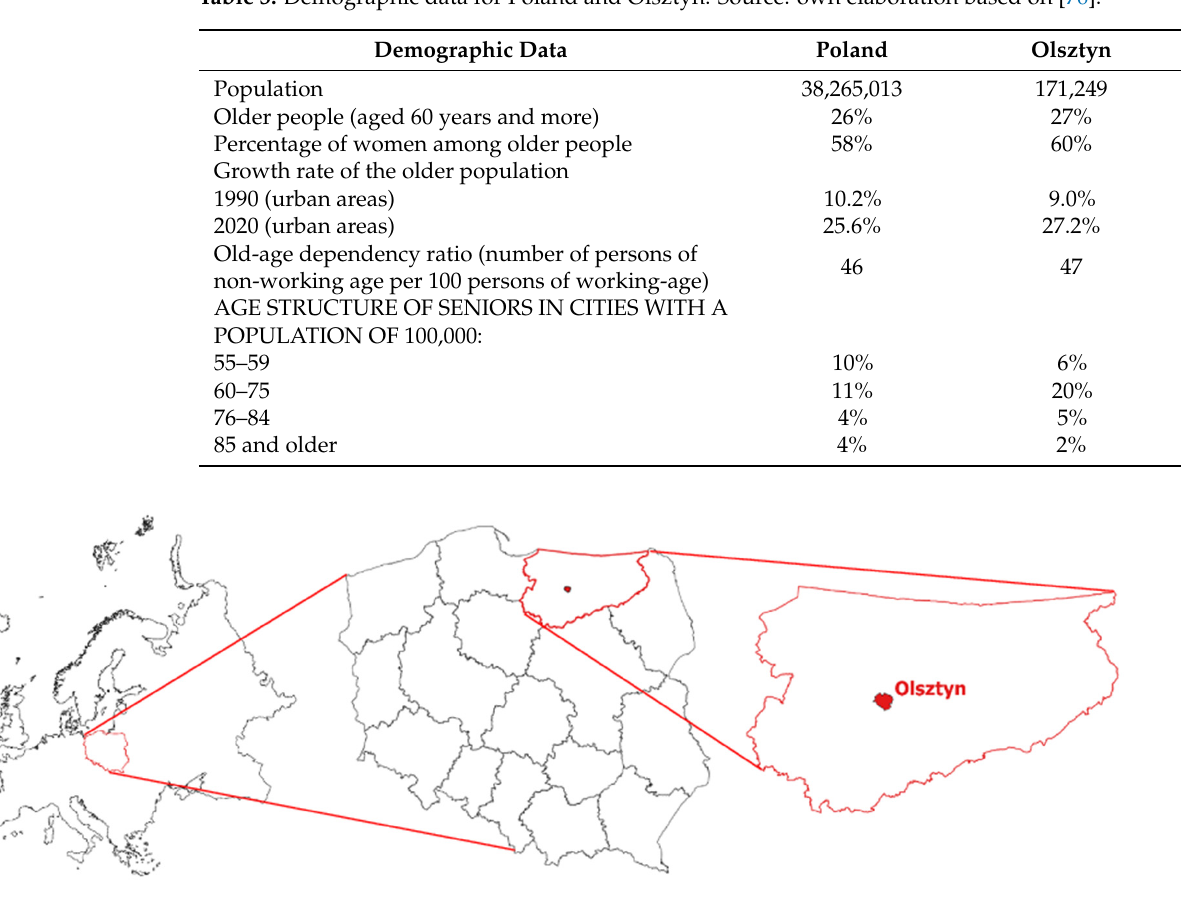
Figure 3. Location of the Voivodship of Warmia and Mazury in Poland ( left ) and Olsztyn in the Voivodship of Warmia and Mazury ( right ). Source: own elaboration.